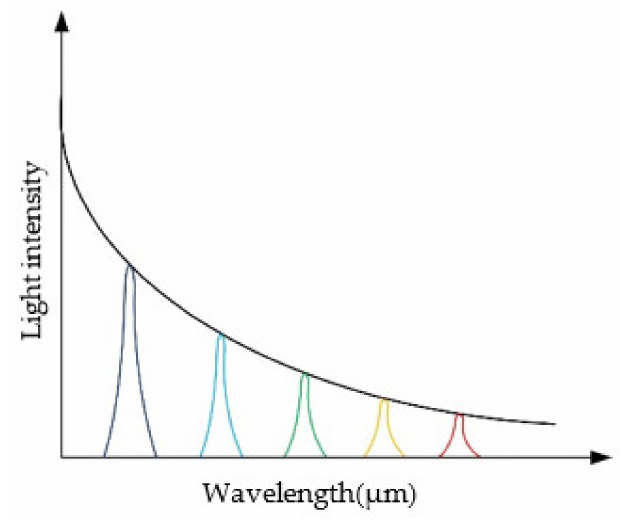
Figure 6. Light intensity distribution with different wavelengths.